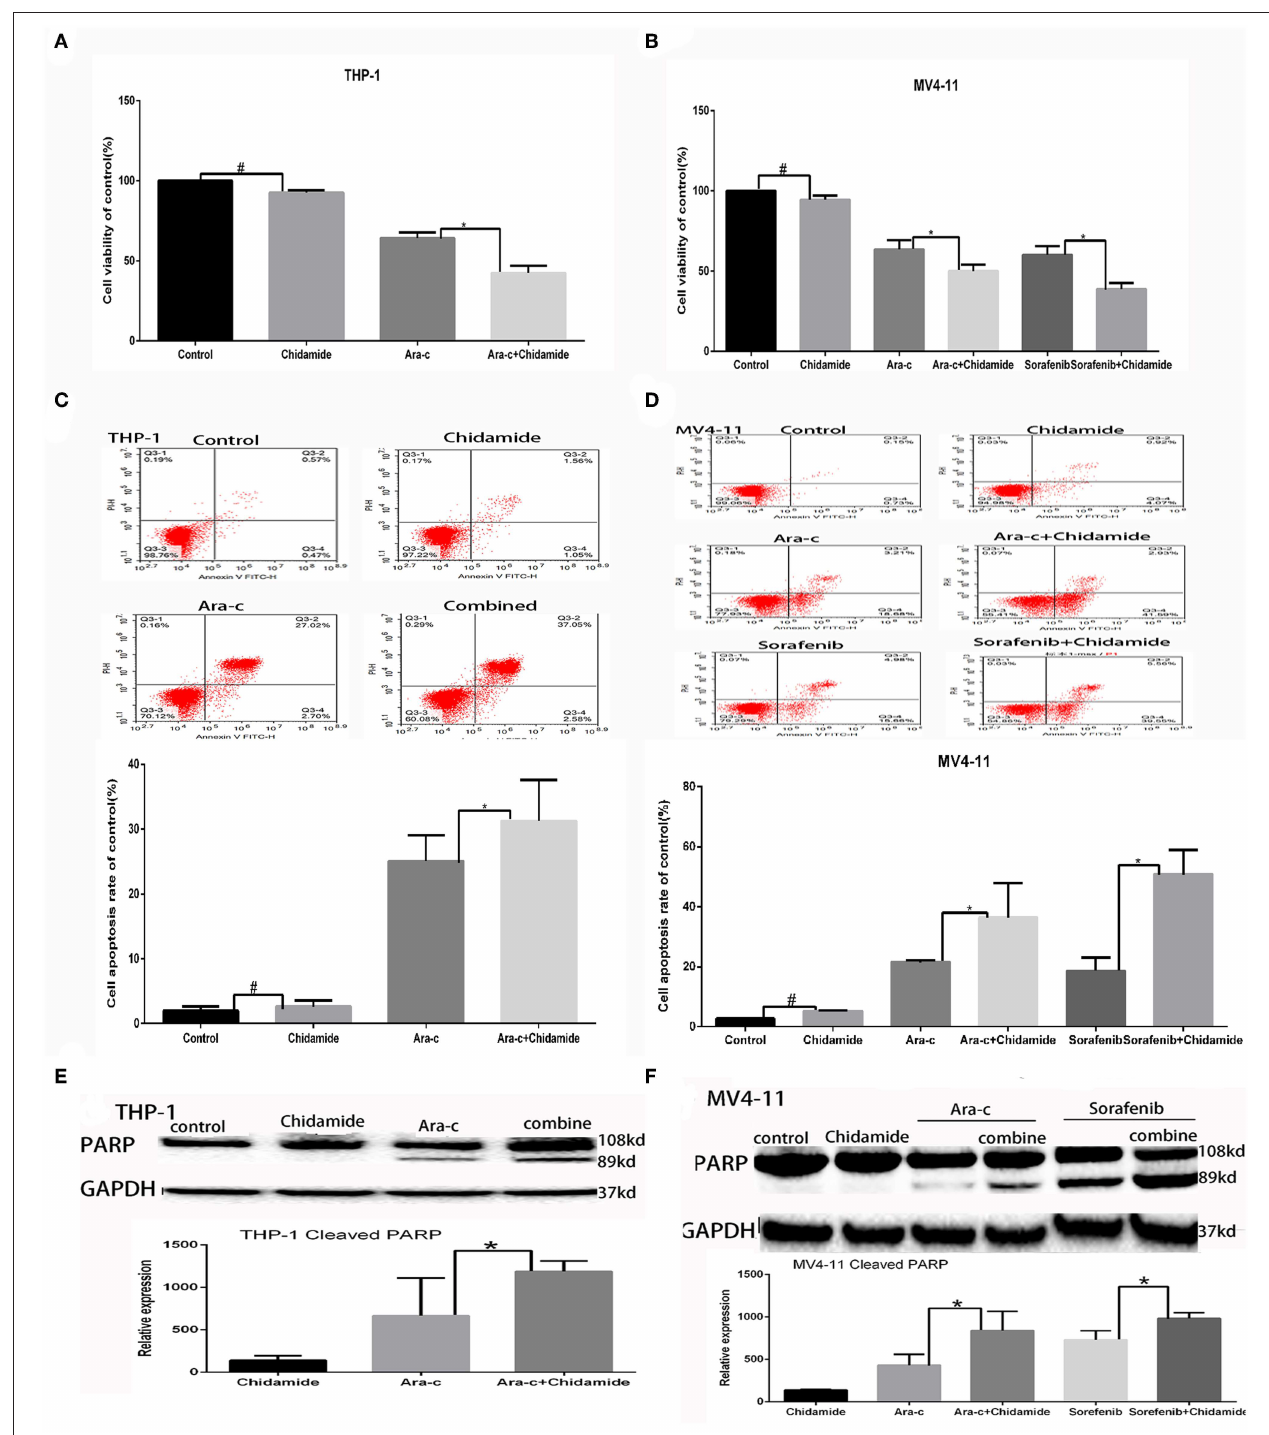
FIGURE 1 | Low-dose chidamide enhanced the cytotoxicity of chemotherapy drugs in acute myeloid leukemia cells. (A) MTT assays was performed on THP-1 cells treated with Ara-c alone or in combination with chidamide for 24h, and the proliferation rate of THP-1 cells in combination with chidamide team was inhibited much more than THP-1 cells treated with Ara-c alone. (B) MTT assays was performed on MV4-11 cells treated with Ara-c or sorafenib alone or in combination with chidamide for 24h, and the proliferation rate of MV4-11 cells in combination with chidamide team was inhibited much more than MV4-11 cells treated with Ara-c or sorafenib alone. (C) Flow cytometry assays were performed to evaluate the apoptosis of THP-1 cells treated with Ara-c or in combination with chidamide for 24h, and the apoptosis rate of THP-1 cells in combination with chidamide team was higher than THP-1 cells treated with Ara-c alone. (D) Flow cytometry assays were